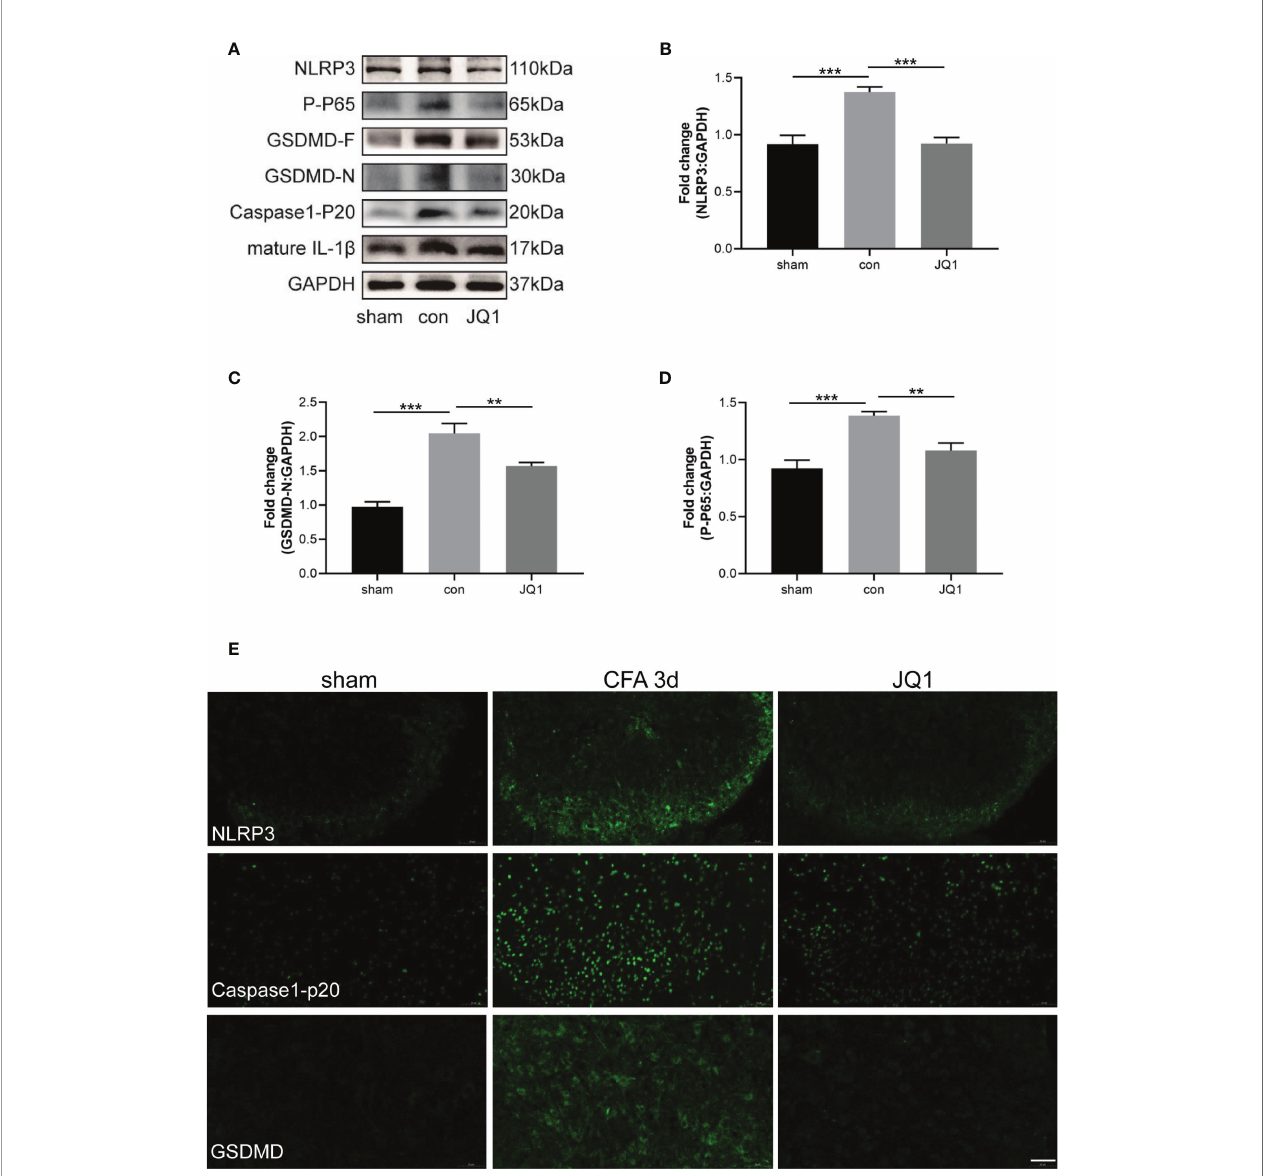
FIGURE 4 | BRD4 inhibitor alleviated CFA-induced in fl ammatory pain by inhibiting neuronal pyroptosis. (A) Western blot assaied of NLRP3, GSDMD-F, GSDMD-N, caspase-1-P20, mature IL-1 b , P-P65 in sham, control and JQ1 group. (B – D) Subsequent quantitative analysis of NLRP3, GSDMD-N, P-P65 expression, n=4 mice/ group. (E) Proteins expression were also re fl ected by Immuno fl uorescence intensity in the dorsal horn of the spinal cords at different groups, Bar=50 µm, n=4 mice/ group. Data were presented as mean ± standard deviation (SD). (**P < 0.01, ***P <